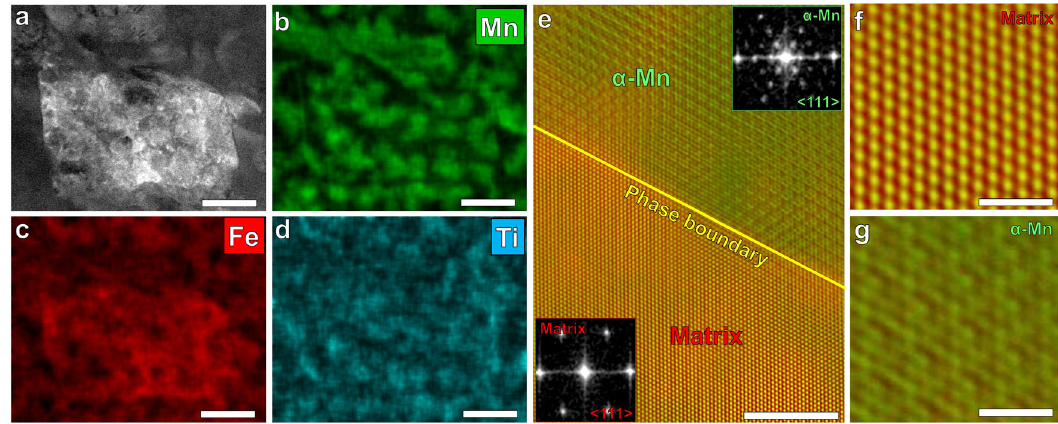
Fig. 3 HRTEM characterization. Fe18Mn3Ti alloy aged during 6 h@450 °C. a – d Energy-dispersive X-ray spectroscopy of a martensitic region with precipitation of α -Mn A12 phase (Mn-rich). Scale bar: 100 nm. e interface between BCC matrix (red) and α -Mn A12 phase (green). The insets are corresponding FFTs displays the cube-on-cube orientation relationship. Scale bar: 5 nm. f , g atomic resolution image of the BCC matrix and α -Mn A12 phase, respectively. Scale bar: 1 nm.